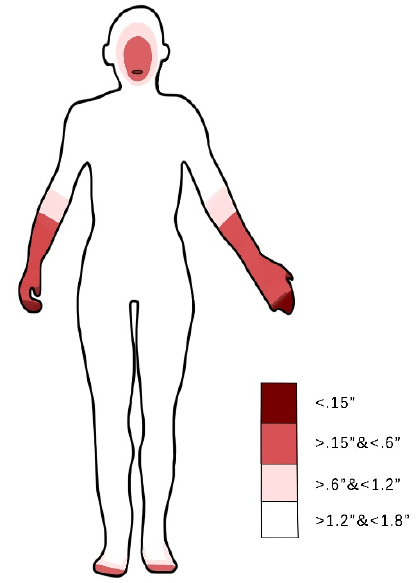
Figure 3. Average distance in two-point discrimination sensitivity test on body locations; data were taken from the associated website of Reference [51] .